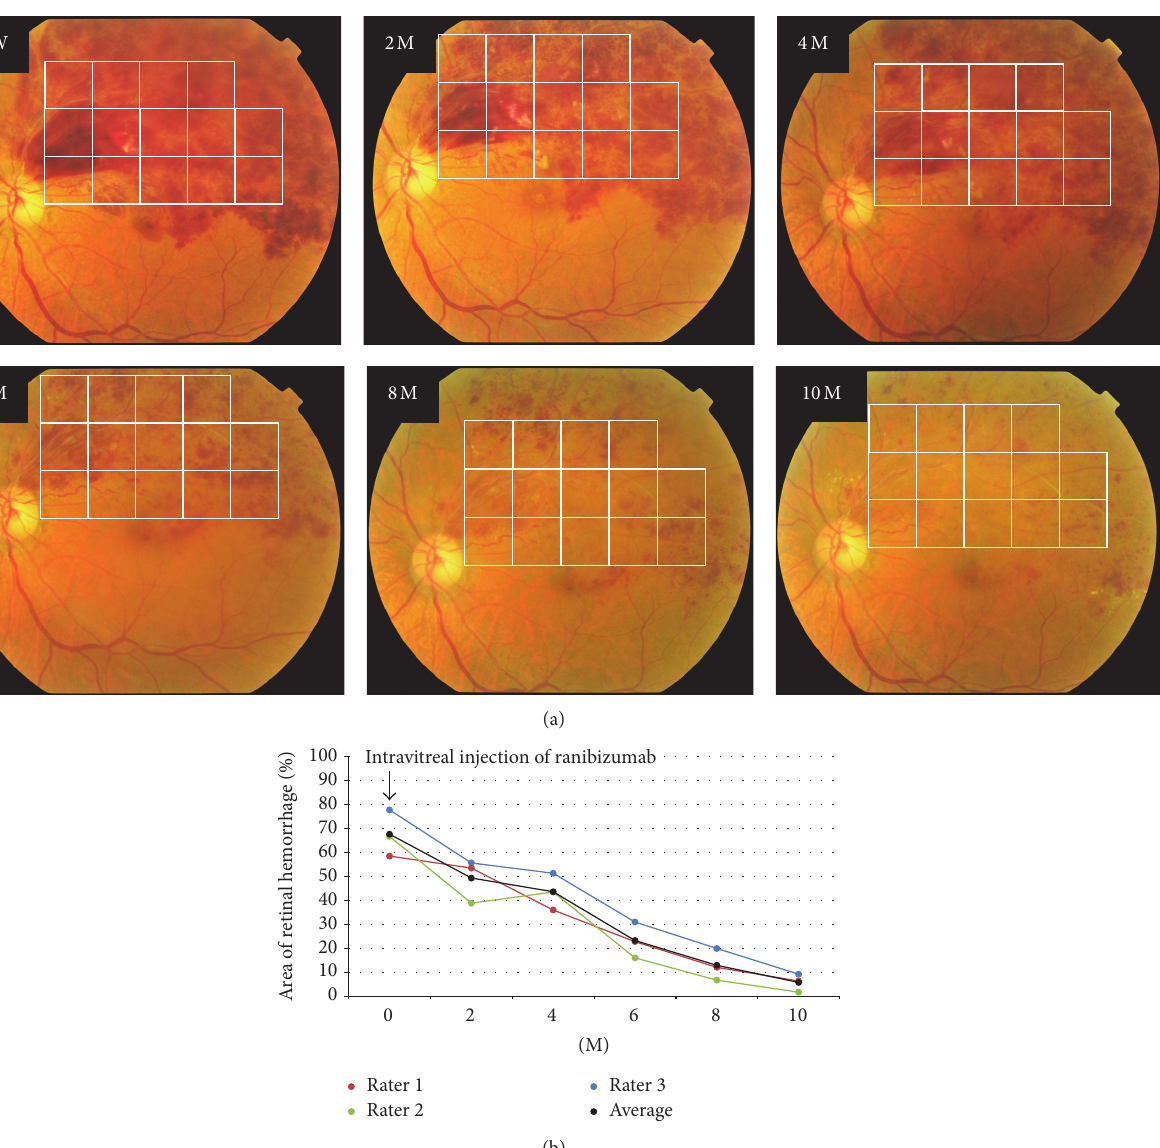
Figure 4: Changes in the retinal hemorrhage area over the time in an eye with BRVO. The retinal hemorrhage area was measured by the three raters using a grid with 14 squares at the initial visit (0) and at 2, 4, 6, 8, and 10 months after the initial visit. Intravitreal ranibizumab was injected at the initial visit. Fundus photographs at each time point are shown in (a), and values of retinal hemorrhage size measured by each three raters and averaged values are plotted in